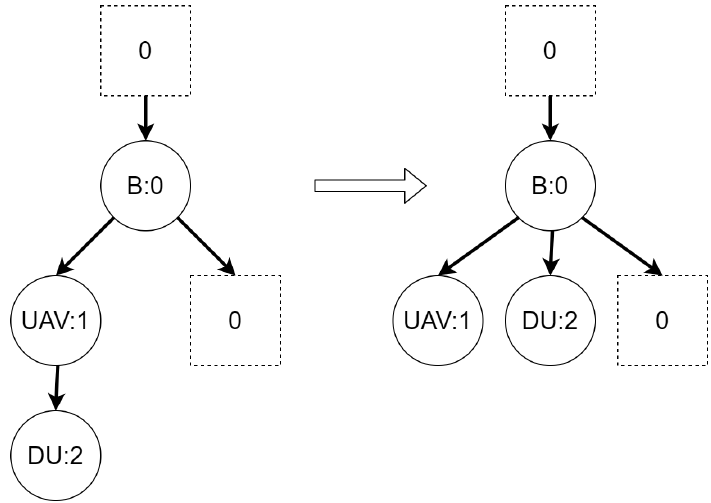
Figure 12. Reaction rule deploy data for scenario 2.